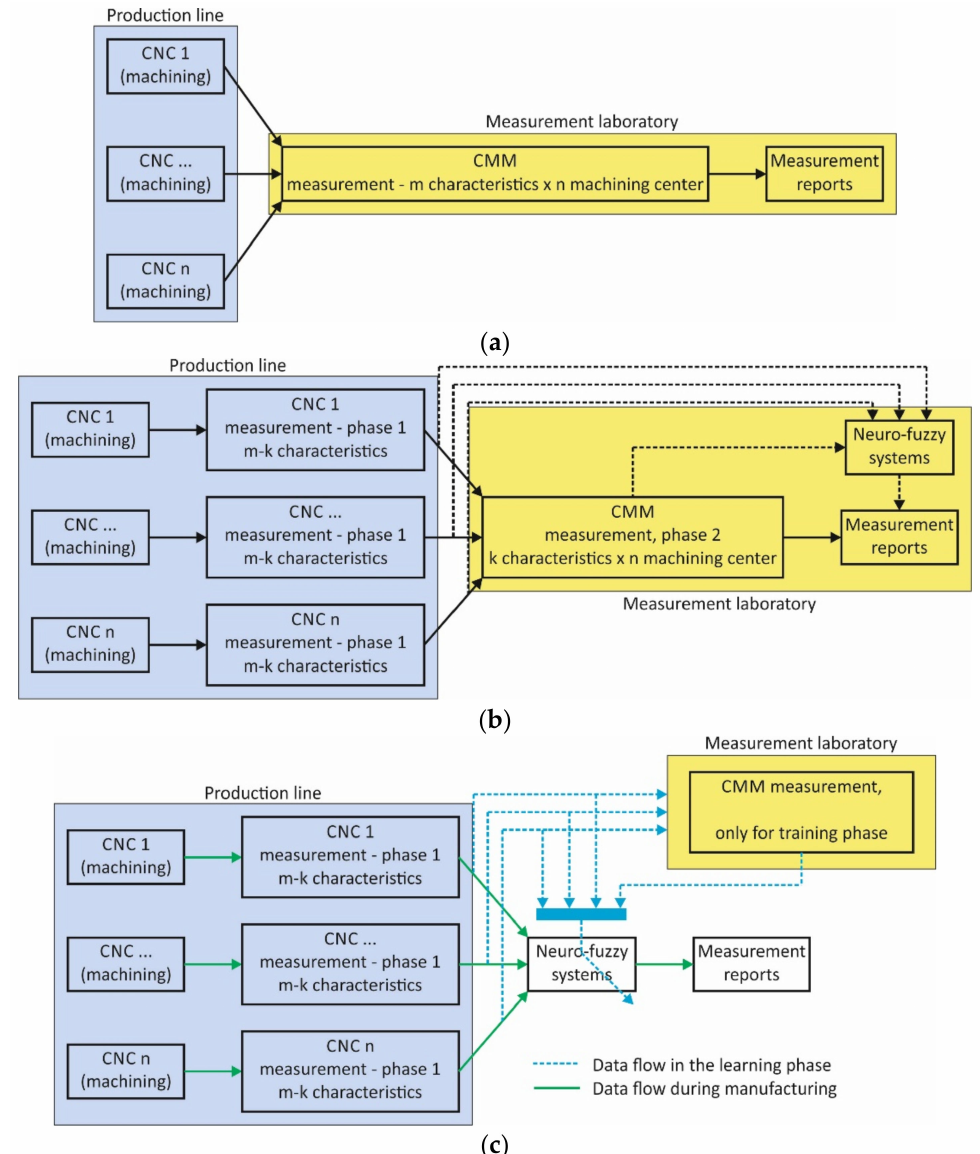
Figure 3. Quality control of production: ( a ) carried out entirely in the measurement laboratory; ( b ) carried out in a large part on the production line; ( c ) carried out entirely on the production